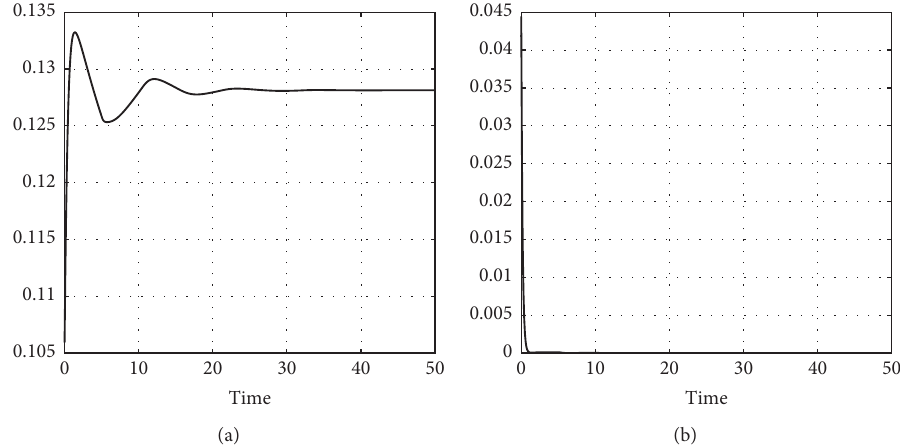
Figure 3: The dispersion and disagreement of the leadership of CS model with time delay τ � 2 for t ∈ [ 0 , 50 ] . (a) X ( t ) . (b) V ( t )